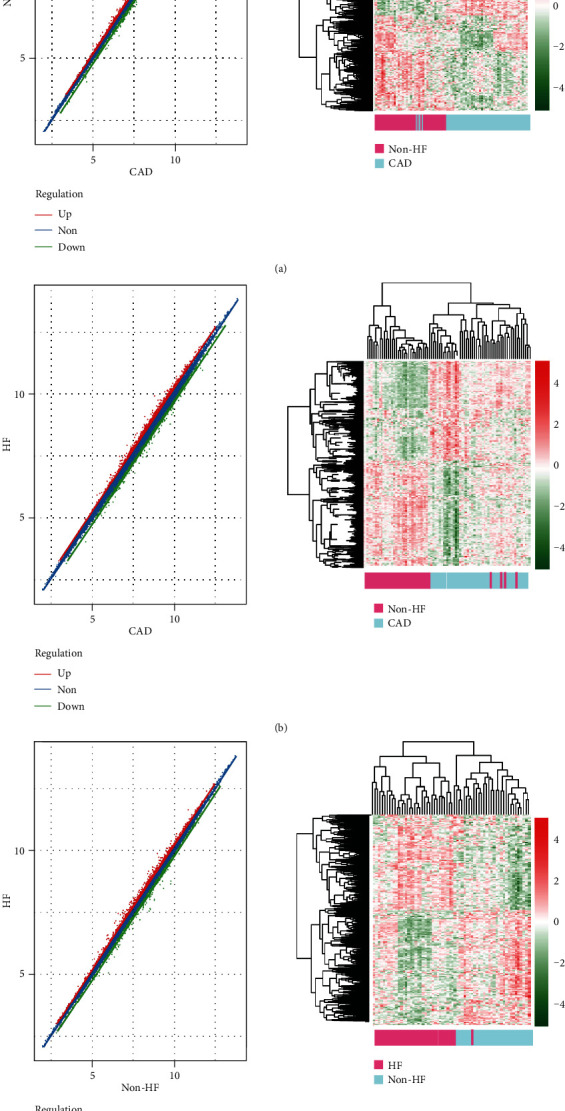
The scatter distribution map and bidirectional hierarchical clustering map based on DEG expression level in the CAD vs. MI without HF group (a), CAD vs. MI with HF group (b), and MI with HF vs. MI without HF group (c).